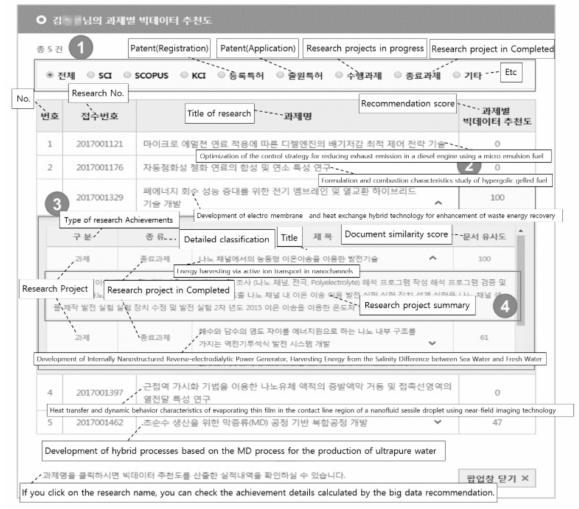
Figure 4. The outputs on the similar achievements and score of evaluator candidate